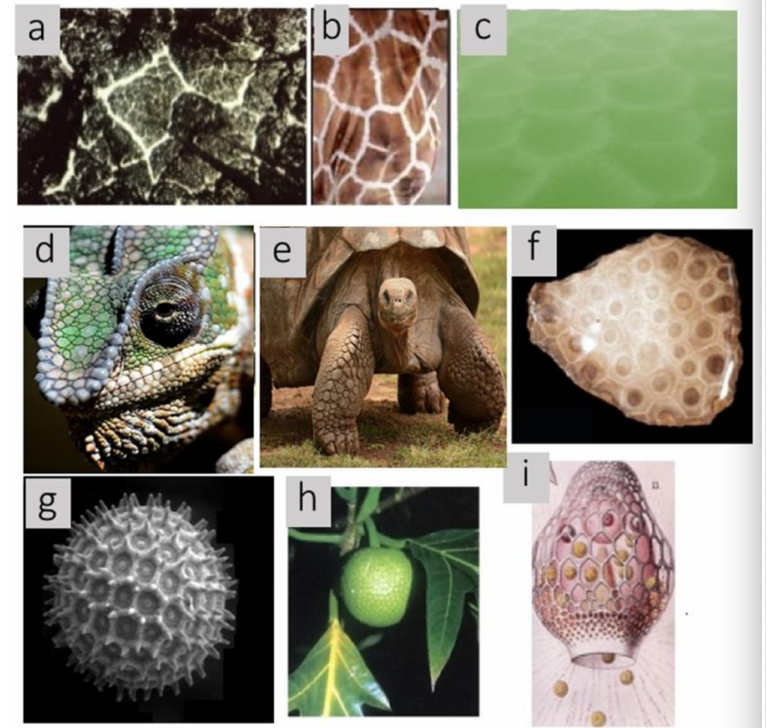
Figure 1. Consider the nine images above: ( a ) tropical rain forest canopy; ( b ) reticulated giraffe; ( c ) Tilapia fish territories; ( d ) Chameleon head; ( e ) Galapagos tortoise forefoot; ( f ) Petoskey stone ( a ) fossilized stony coral); ( g ) pollen grain; ( h ) Thai breadfruit (Artocarpus altili )); and, ( i ) radiolarian. (Figure 1a,b,d,e,g from https://commons.wikimedia.org/ accessed on 25 October 2021). Figure 1c from (http://www.finterest.com.au/ accessed on 25 October 2021); Figure 1f–h by author. Figure 1i is from Haeckel’s Art Forms in Nature (http://www.rarebooksberlin.de/fileadmin/haeckel_artforms. pdf (accessed on 25 October 2021) and see also Wagner and Jungck-Microscopy of Radiolarians and Foraminiferans https://spark.adobe.com/page/lm464/ (accessed on 25 October